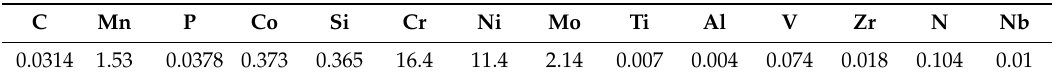
Table 1. Chemical composition (%).